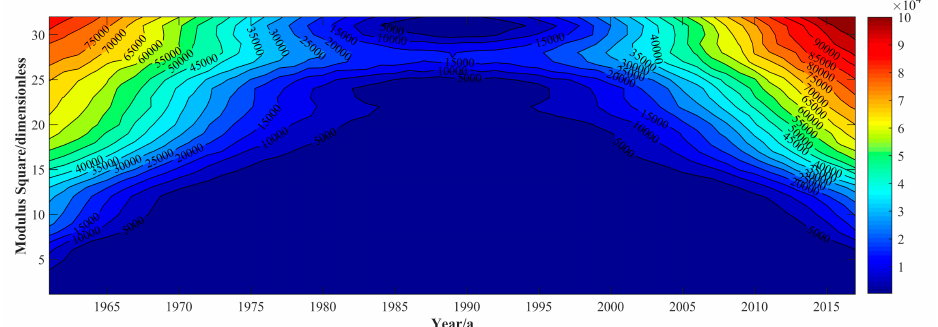
Figure 11. Time-frequency distribution of the wavelet transform modulus.